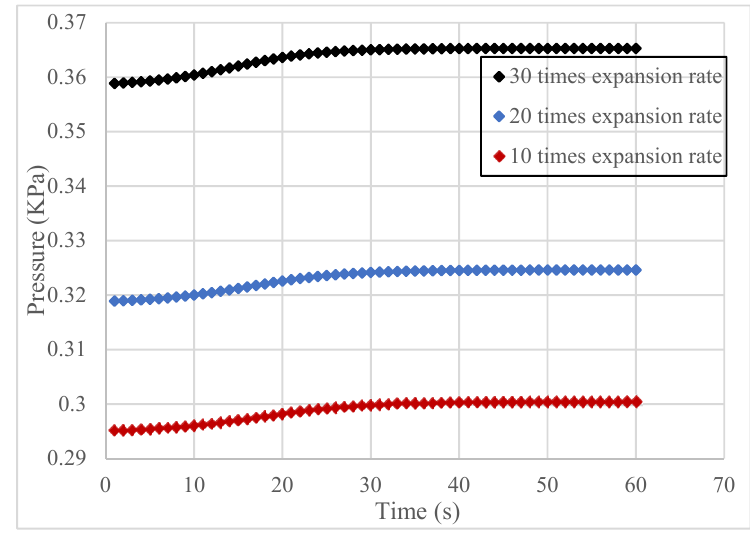
Figure 14. Pressure versus time curves at different expansion ratios.